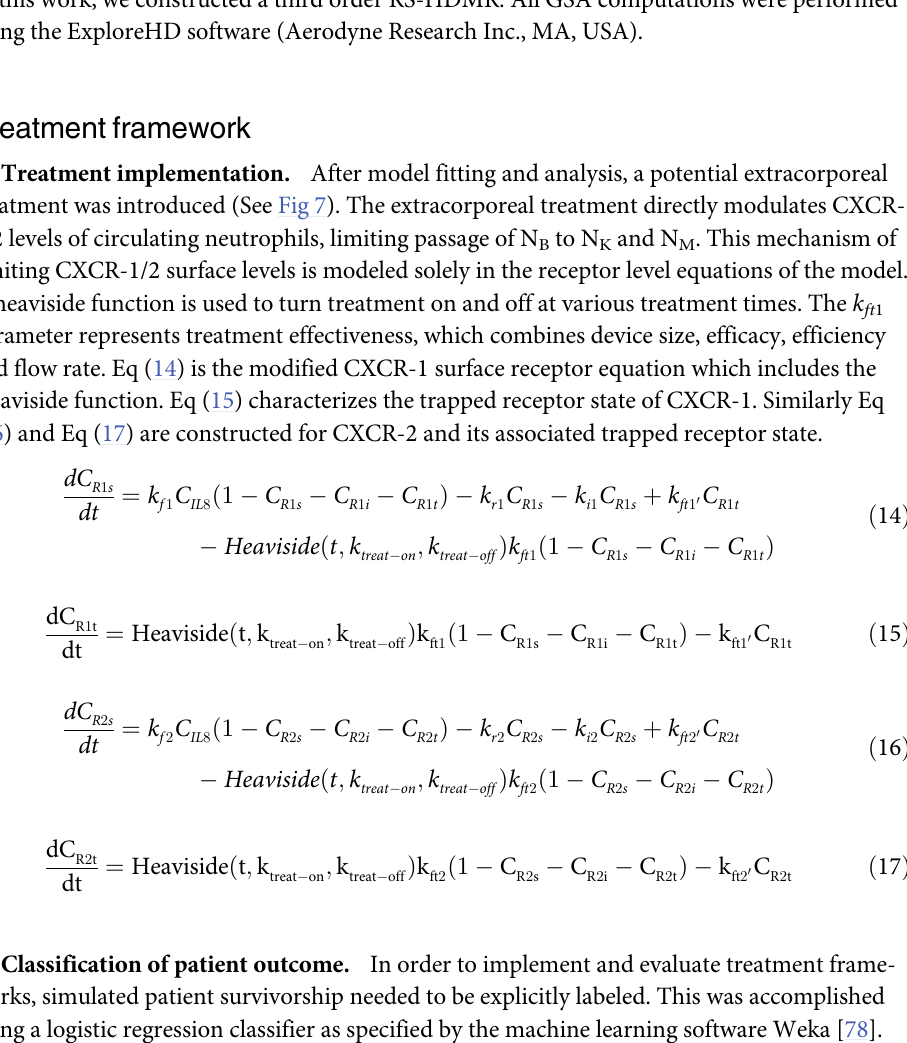
S1 Fig. Model predictions of receptor dynamics following infection. Mean (red), 25 th -75 th percentile (dark blue), and 5 th -95 th percentile trajectories of the simulated ensemble are shown. Predictions are shown for the CXCR1 (A-B) and CXCR2 (C-D) bound to IL-8 and actively sig- naling from the cell surface, as well as internalized and unable to